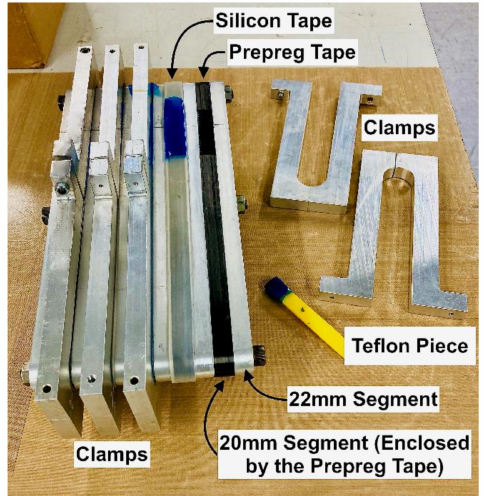
Figure 6. Mould, with features labelled.